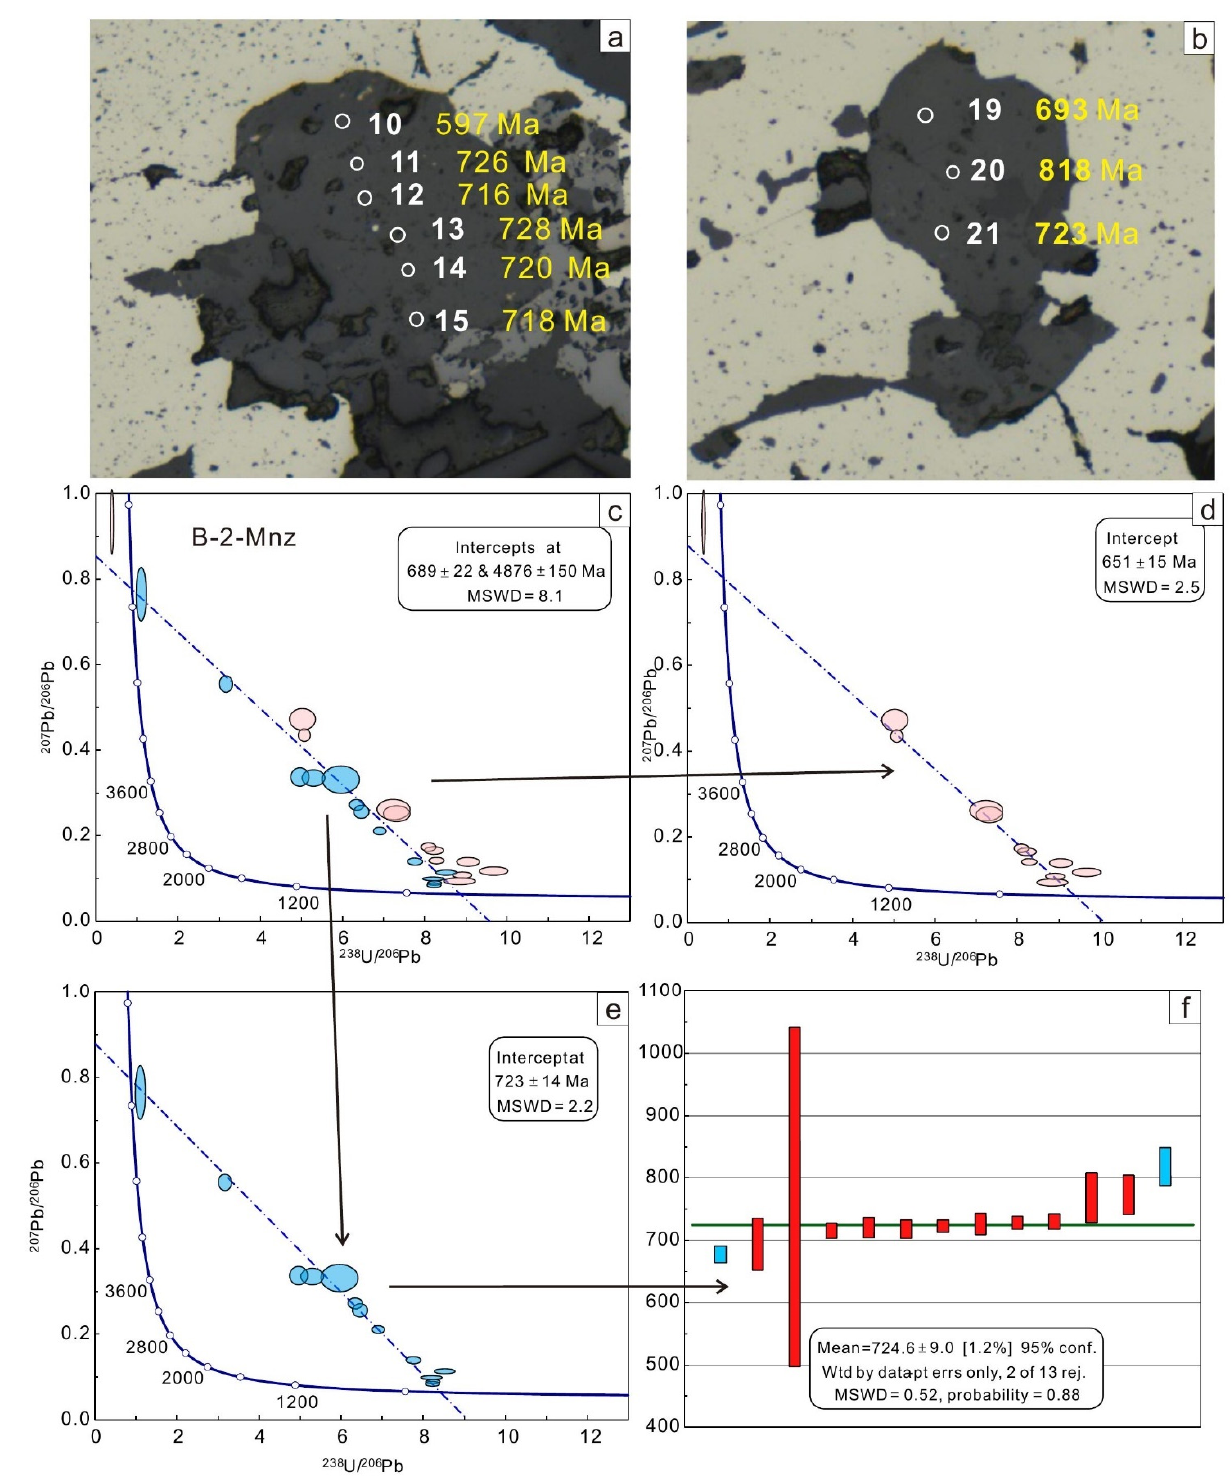
Figure 10. Monazite Concordia diagram of sample B-2 from the Bayan Obo deposit. ( a , b ) The detail testing locations and age distribution characteristics in monazite. ( c ) The Intercept age of all dates. ( d ) The Intercept age of the pink group. ( e ) The Intercept age of the blue group. ( f ) The mean age dates of the blue group.